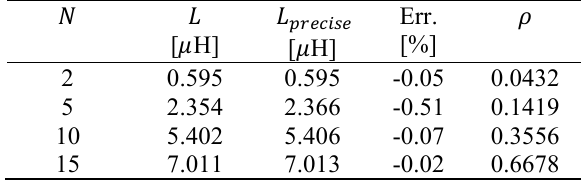
Table 5 lists the number of windings 𝑁 to be used for each of the four ranges in the test, together with the respective value of 𝐿 returned by the MATLAB function, the precise DC in- ductance, the relative error of 𝐿 , and the value of 𝜌 returned. Table 5: Example data for testing the MATLAB function pre- sented in appendix